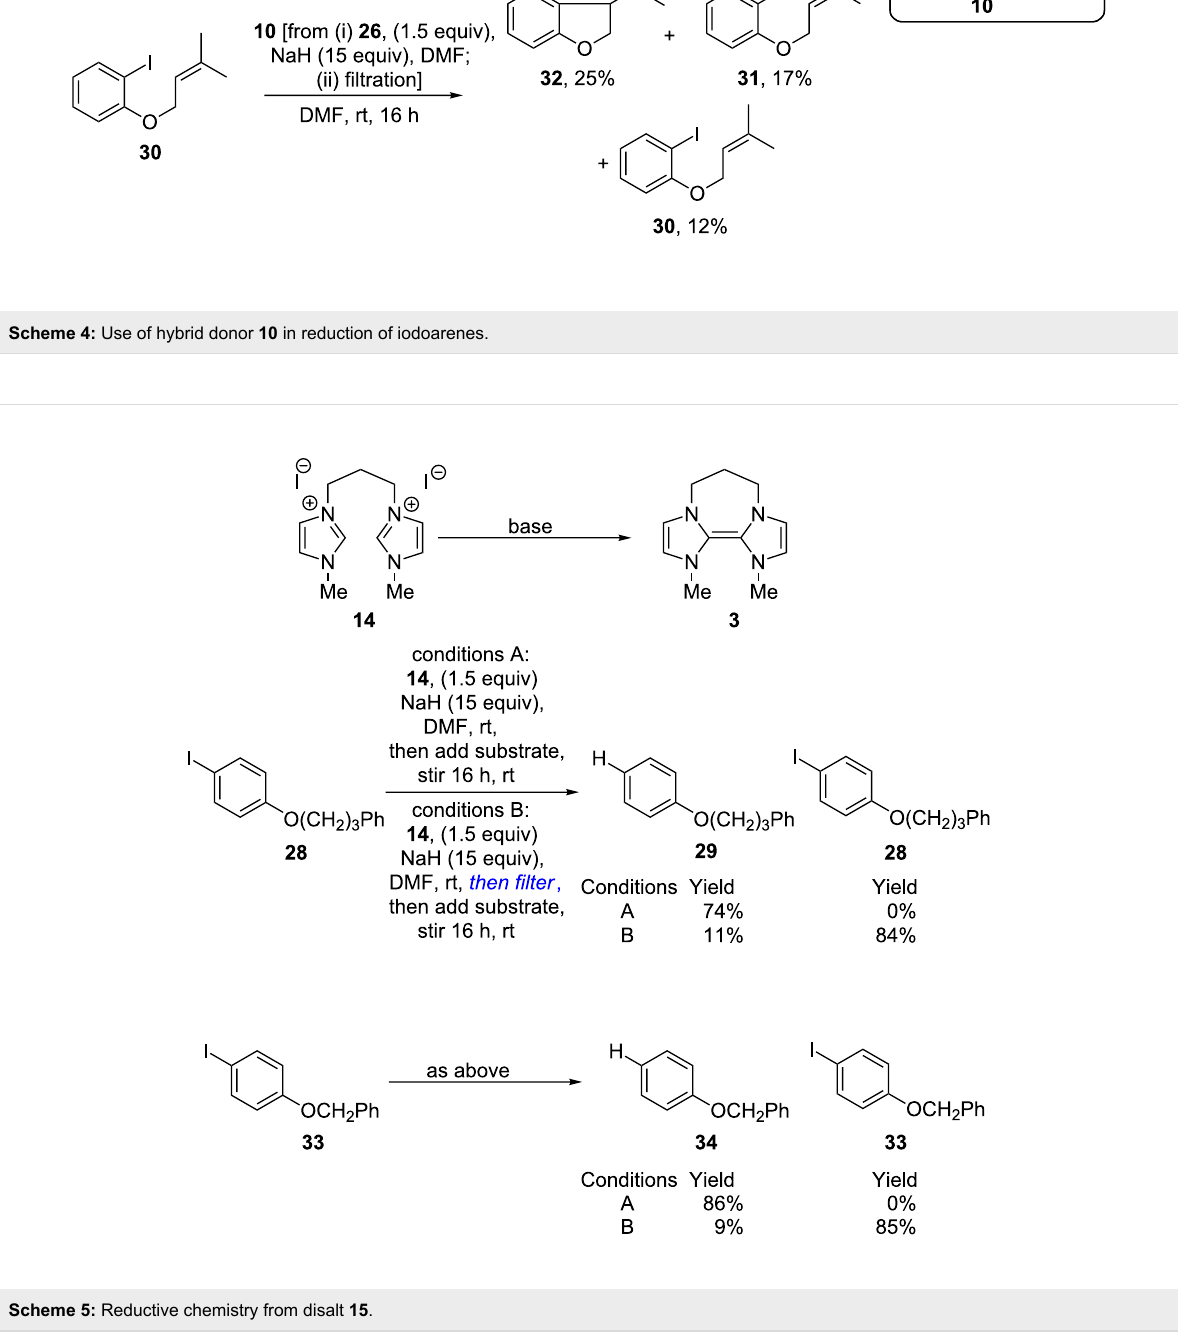
Scheme 5: Reductive chemistry from disalt 15